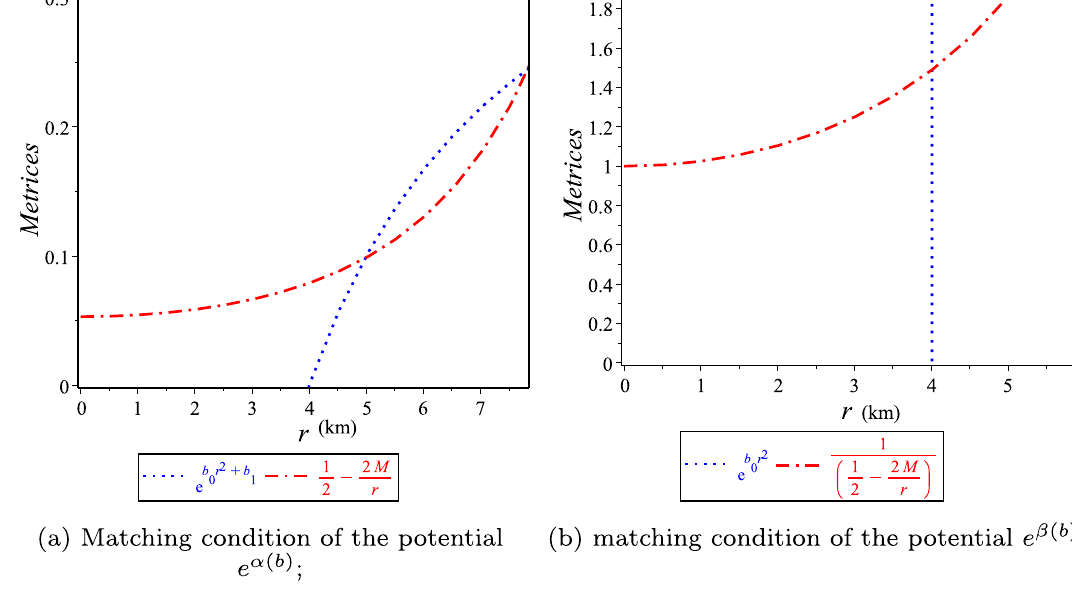
Fig. 2 Plot of boundary matching of a g tt and b g rr of